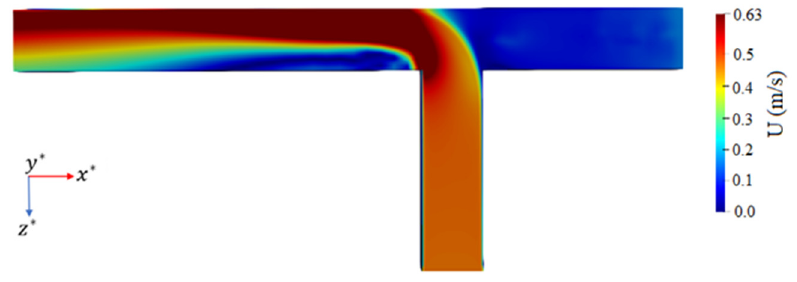
Figure 16. The distribution of water surface velocity (Realizable k- ε ).